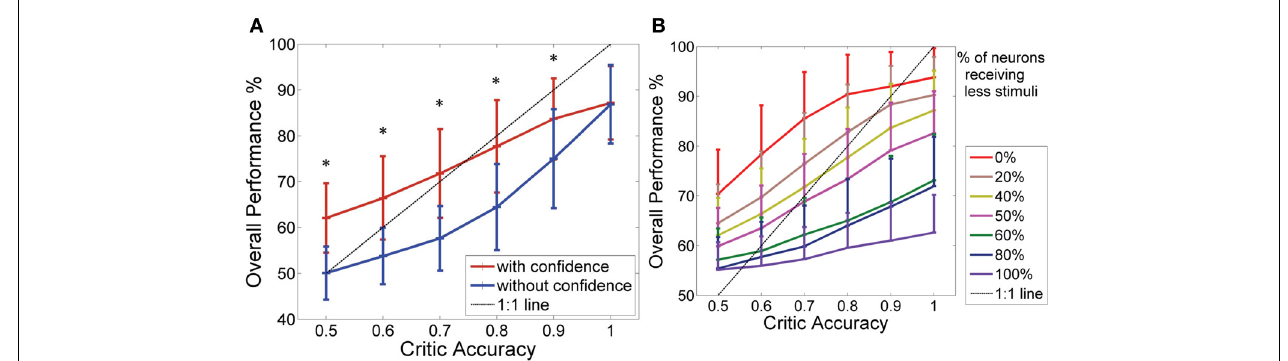
(alpha 0.001). The overall performance of the blue curve is limited by the accuracy of the critic but the overall performance of the red curve is able to go beyond the critic accuracy. Hence, decoupling the performance from the critic accuracy. (B) How the overall performance changes with the critic accuracy (1000 simulations). Each curve gives a different noise level of the data set. Percentages indicate the percentage of neurons that were given a less